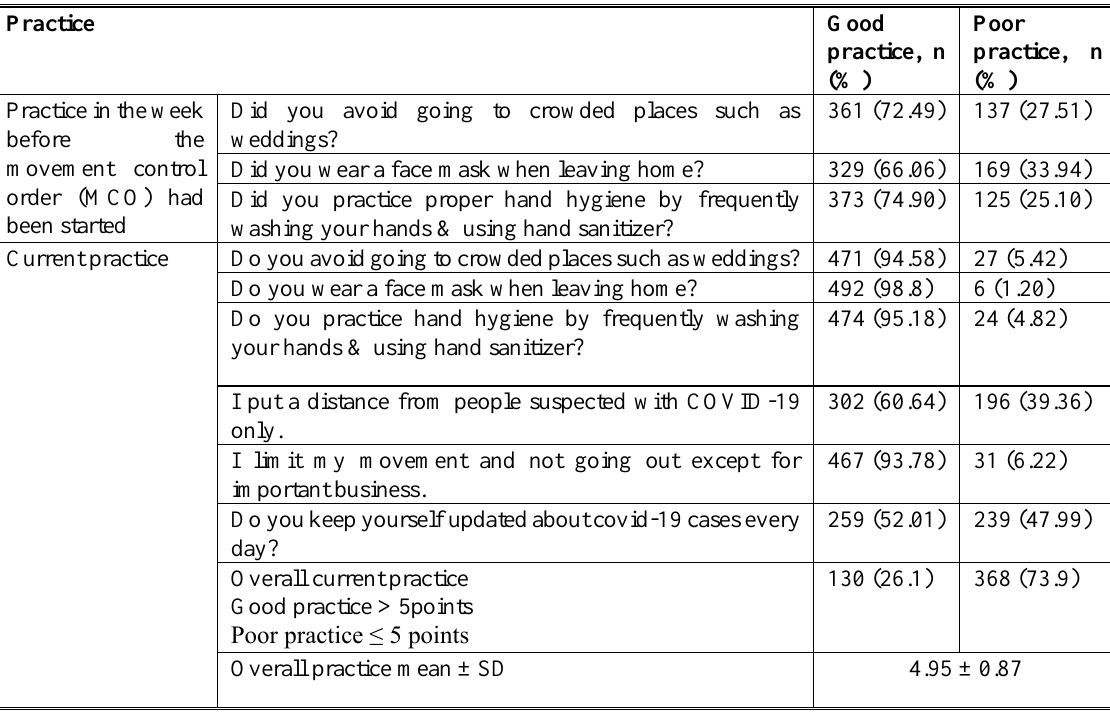
Table 3. Participant's practice towards COVID-19